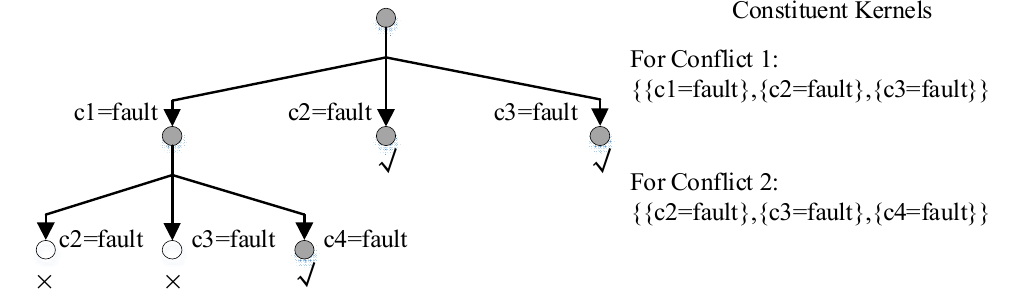
Figure 3. A Search Tree to Find Kernels of Conflict 1 and Conflict 2.